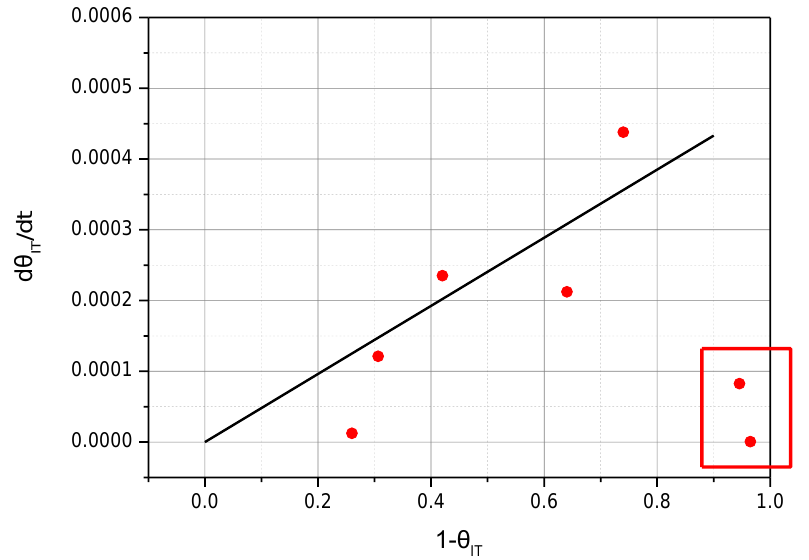
Figure 9. The relationship of d θ IT /dt and (1 − θ IT ) (inlet NH 3 concentration: 200 ppm, temperature of NH 3 absorbing: 50 °C).